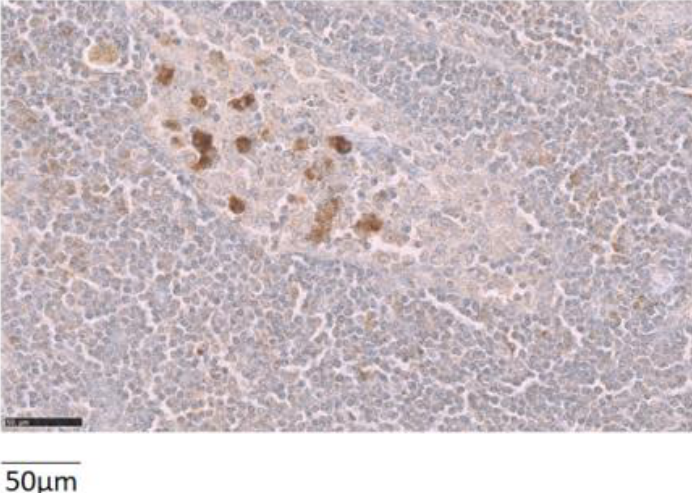
Figure 3. Representative example of the NTR 1 expression in a metastatic lymph node. The image was obtained with 40× magnification.